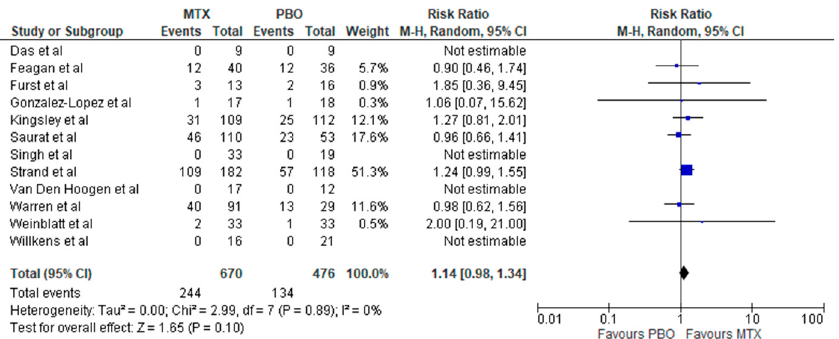
Figure 2. Forest plot: Risk of infection of methotrexate therapy in inflammatory diseases (abbreviations: